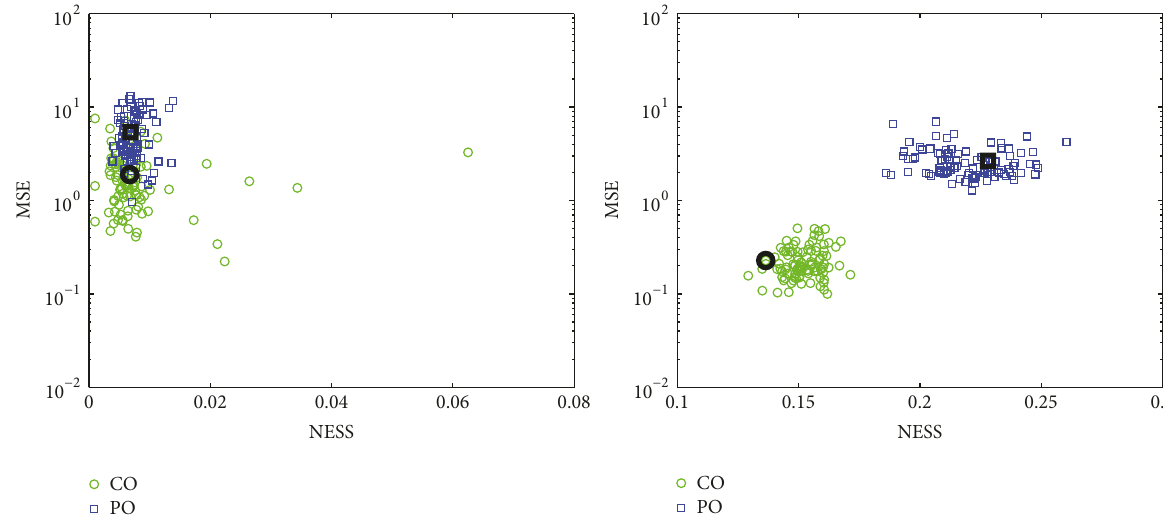
Figure 5: Performance of the pMCMC ( left ) and the NPMC ( right ) methods for the estimation of the whole set of rate parameters 𝜃 : MSE (in logarithmic scale) versus the final NESS, for each simulation run in the CO and the PO scenario. The big circles (CO) and squares (PO) represent simulation runs with a final mean MSE close to the global average.